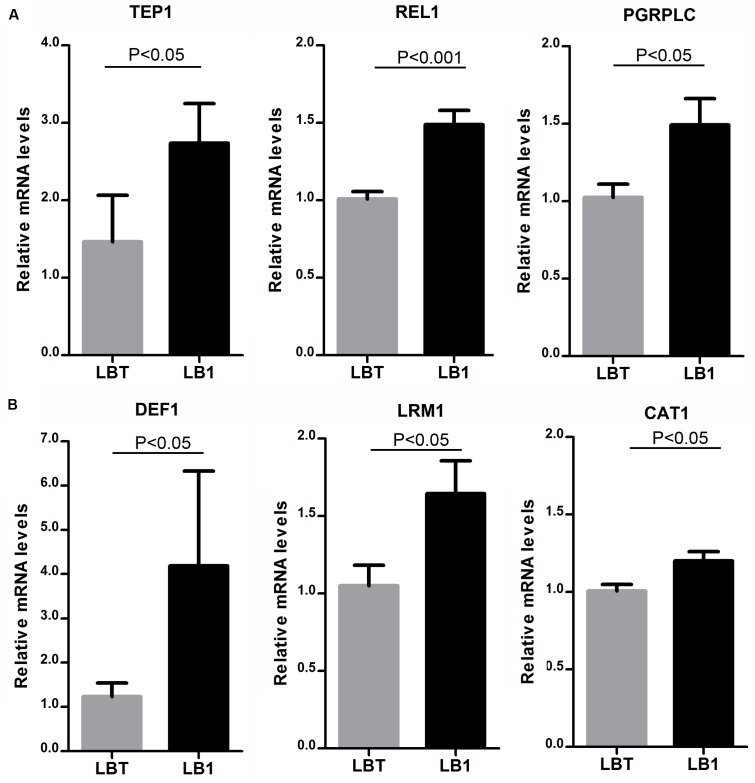
Up-regulation of anti-Plasmodium immune genes by wAlbB in LB1 mosquito. qRT-PCR was used to assess the expression of each of the selected anti-Plasmodium immune genes in either midguts (A) or the remaining carcass tissues (B), with the host RPS6 as an internal reference control to normalize the data. 2-ΔΔCT method was used to calculate fold change for each gene and significance was determined based on comparison of ΔCT of each gene in LB1 and LBT. P-value is indicated based on Mann–Whitney test.